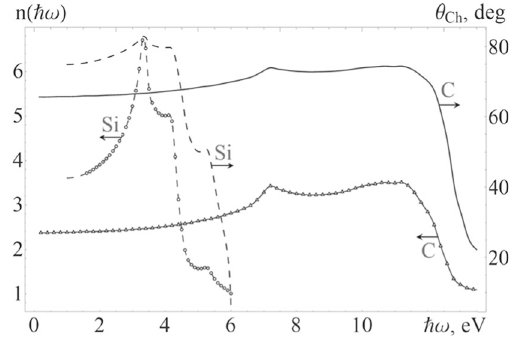
Fig. 1 Refractive indexes n = n (ω) (dot-solid lines related to the left ordinate) and Cherenkov angles versus ChR photons energy (solid and dashed lines related to the right ordinate) for both C and Si crystals. Dots indicate the experimental data [18]